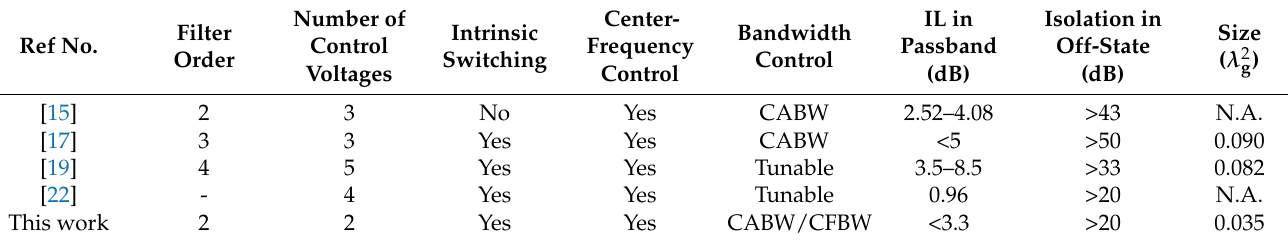
Table 3. Comparisons with previously reported switched tunable